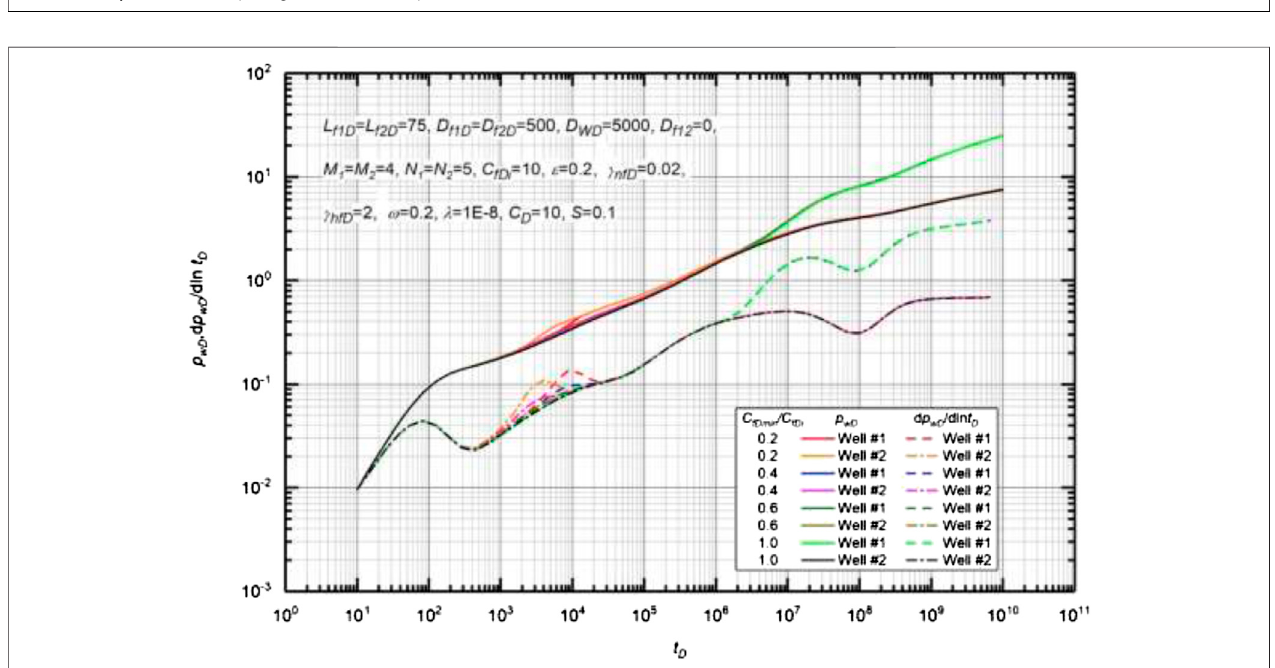
FIGURE 13 | Effect of minimum fracture conductivity on the transient pressure for